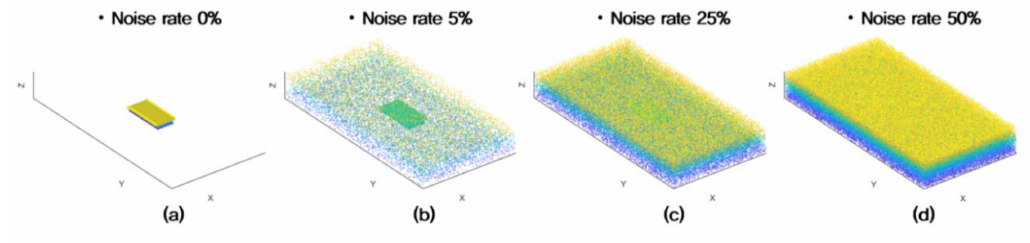
Figure 16. A building information modeling (BIM) model-based validation dataset ( a ) w / o noise, ( b ) w / 5% noise, ( c ) w / 25% noise, and ( d ) w / 50%